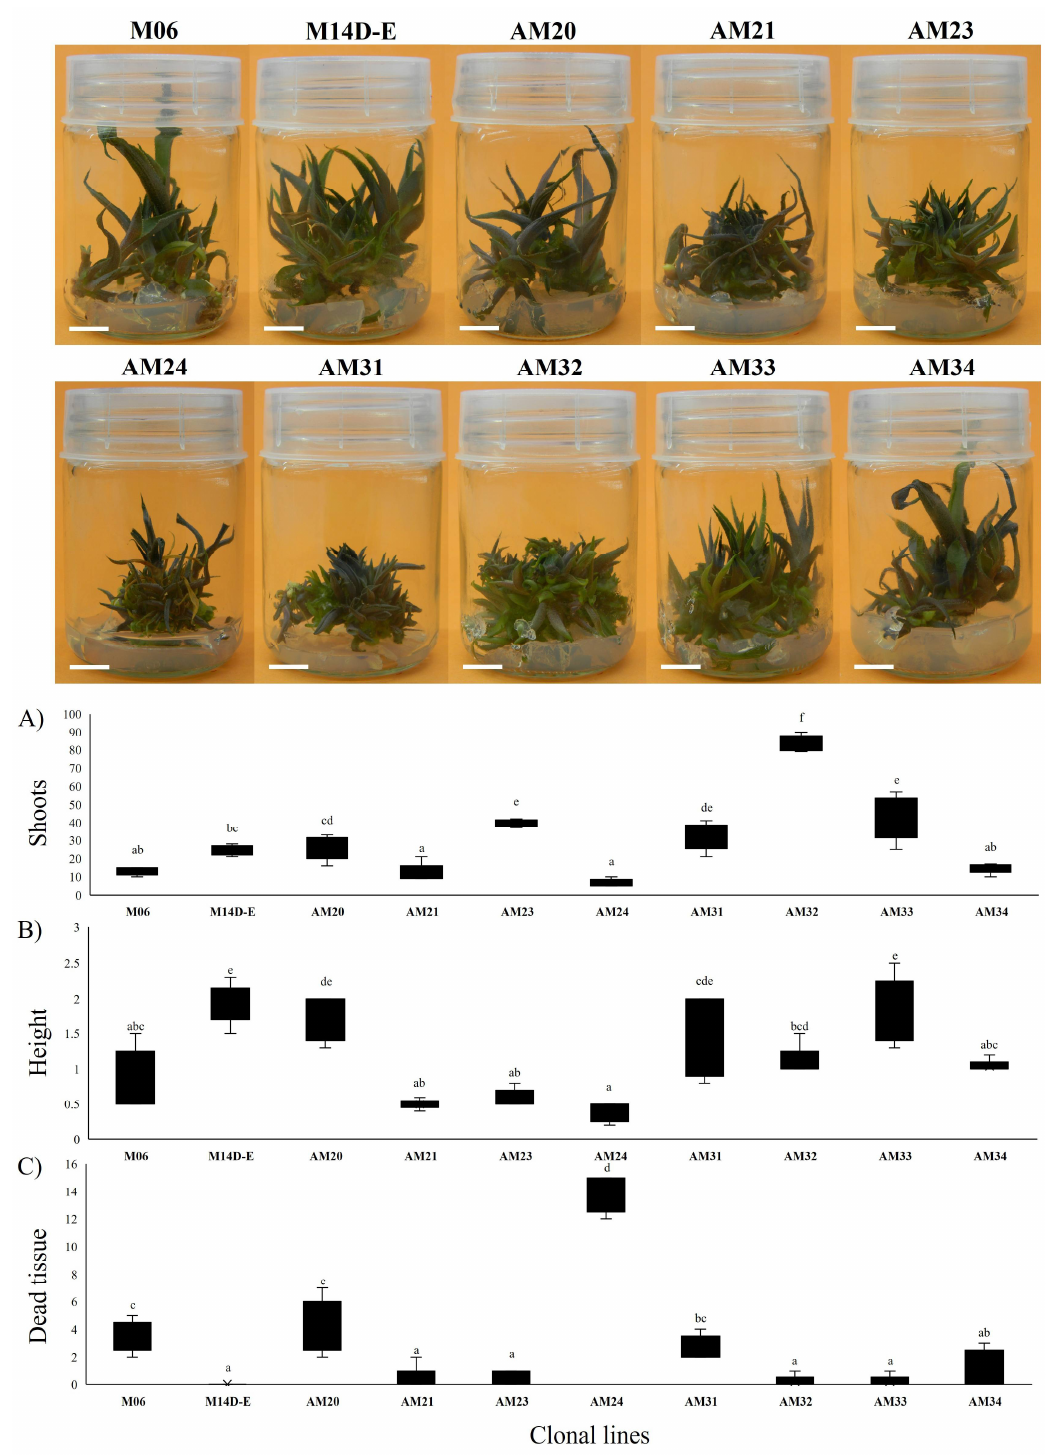
Figure 3. Effect of BAP cytokinin (22.2 µ M) on axillary bud proliferation of seed-derived clonal lines of A. marmorata on MS medium after 8 weeks of culture. ( A ) Number of shoots formed, ( B ) Shoot height in cm, and ( C ) Number of dry leaves representative of dead tissue. The highest number of shoots was observed in the clonal line AM32, followed by AM33 and AM23. The most stable line was M14d-e which was without senescence tissue. Data are presented as the mean ± SD (top and bottom bars) of results from five repeated experiments. Different letters indicate significant differences, according to Tukey p ≤ 0.05. Bar = 1